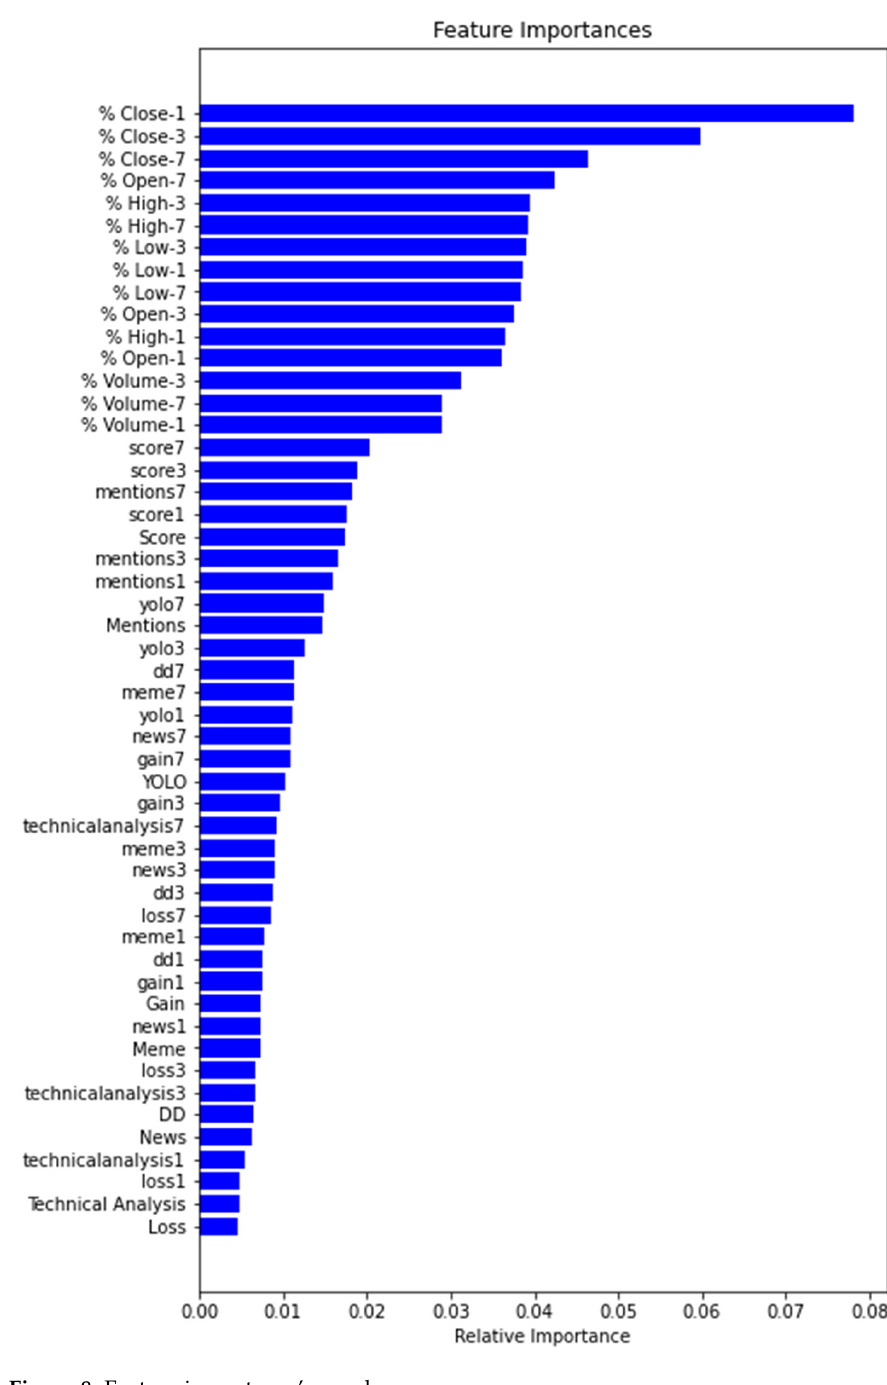
Figure 8. Feature importance’s graph.